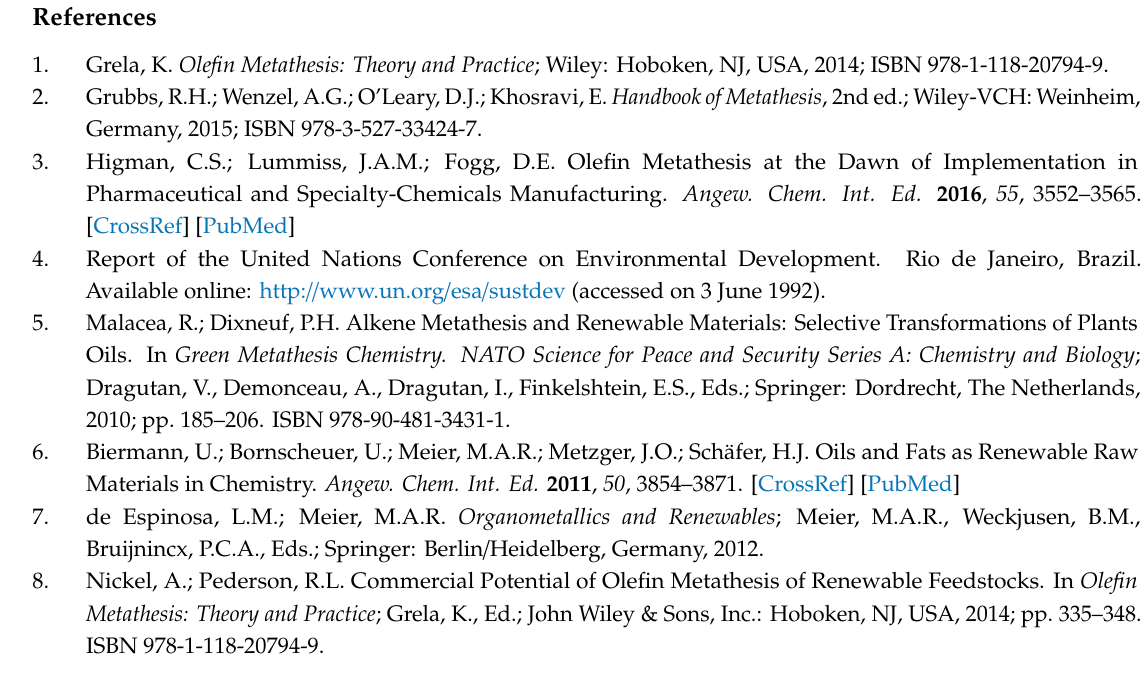
Figure S1: Representative chromatogram of the crude reaction mixture from the CM of 1 and 2 , Figure S2: Representative 1 H NMR spectrum of the CM product ( CM3 ) from reaction of 3 and 4 (CDCl 3 , 400